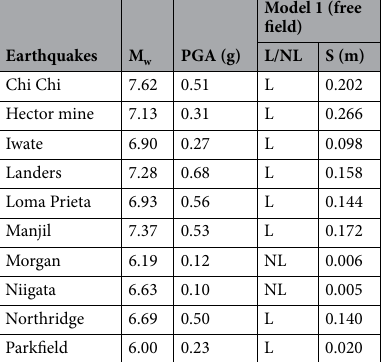
Table 8. Numerical analysis results for Model 1.